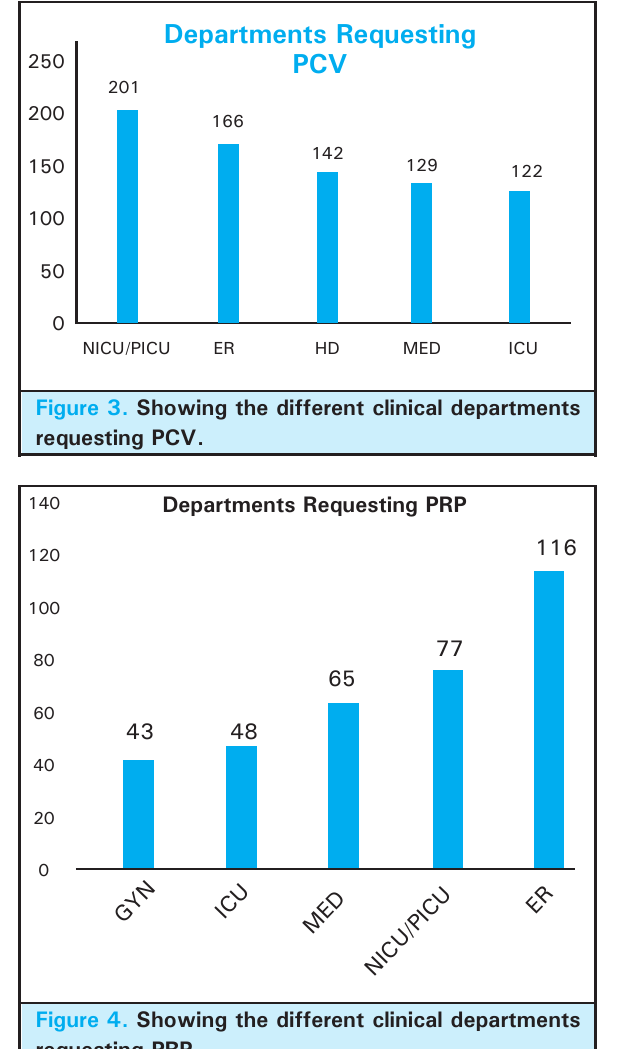
Figure 2. Showing the different clinical departments requesting FFP.